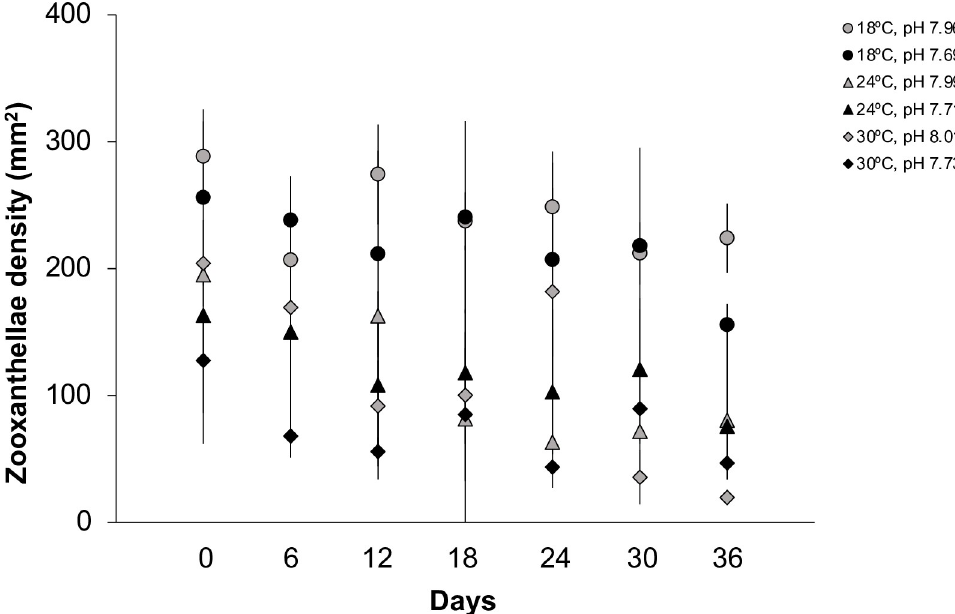
Fig 7. Zooxanthellae density (mm 2 ) within the polyps of Cotylorhiza tuberculata under different temperatures (18, 24 and 30˚C) and pH levels (ambient and future). Circle for 18˚C, triangle for 24˚C and rhombus for 30˚C. Grey for ambient pH and black for future pH. Error bars show standard deviation (SD).